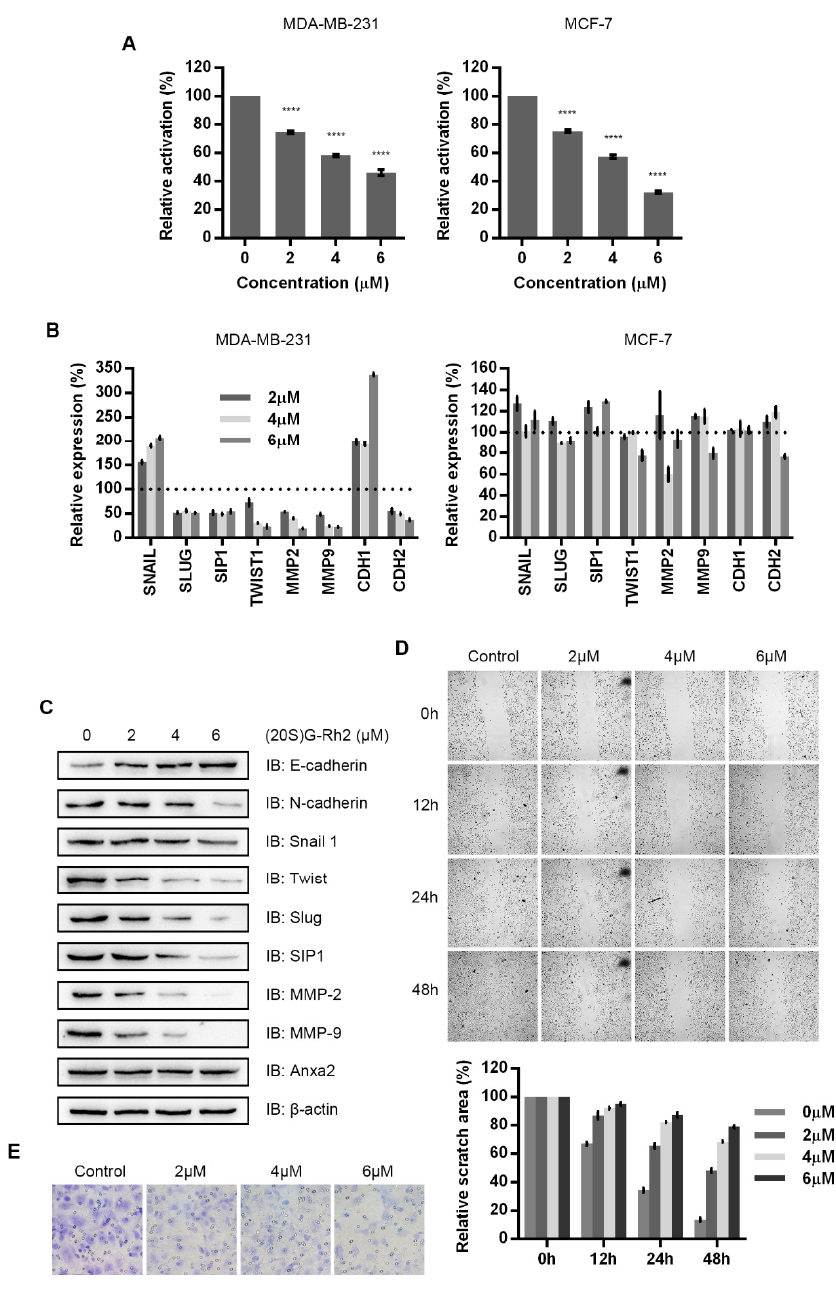
Figure 4. (20S)G-Rh2 inhibits NF- κ B related cell migration and invasion. ( A ) NF- κ B activity was determined via a dual luciferase reporter assay in MDA-MB-231 cells and MCF-7 cells under (20S)G-Rh2 treatment for 12 h. ( B ) mRNA levels of indicated genes were determined by RT-PCR with RNA extract from MDA-MB-231 cells under (20S)G-Rh2 treatment for 12 h. ( C ) The protein levels of indicated genes were determined by immuno-blot in MDA-MB-231 cells under (20S)G-Rh2 treatment for 12 h. A total of 30 µ g of whole-cell protein extract was loaded for immuno-blotting assay. ( D ) A wound healing assay was performed with MDA-MB-231 cells under (20S)G-Rh2 treatment for 12 h. Relative scratch area was shown below the microscopy images. ( E ) A Transwell invasion assay was performed with MDA-MB-231 cells t under (20S)G-Rh2 treatment for 12 h. All experiments were repeated for three times and all data are shown as mean ± SD, with **** presenting p < 0.0001, *** presenting p < 0.001, ** p < 0.01, * presenting p < 0.05 and ns presenting p >